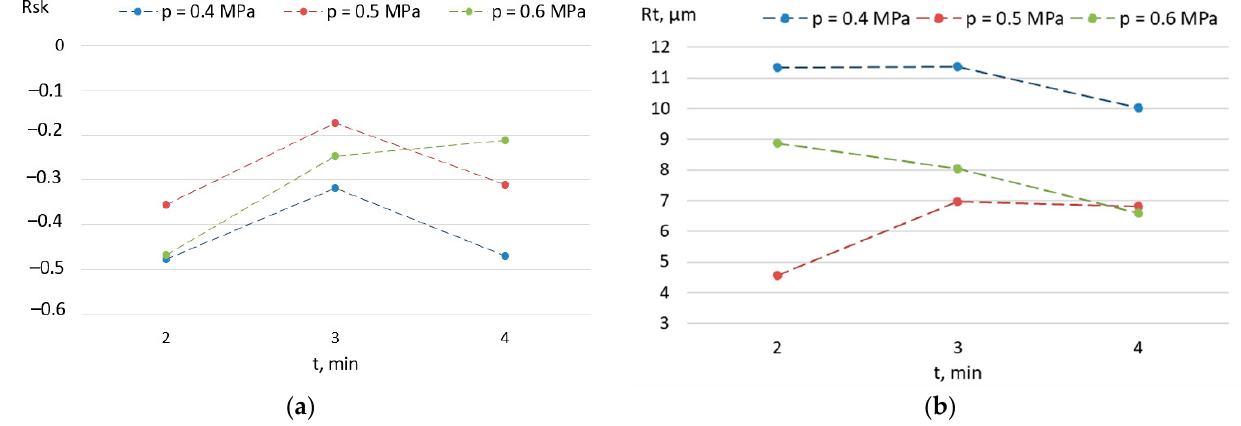
Figure 7. Effect of SP parameters on the value of the ( a ) Rsk and ( b ) Rt parameters.